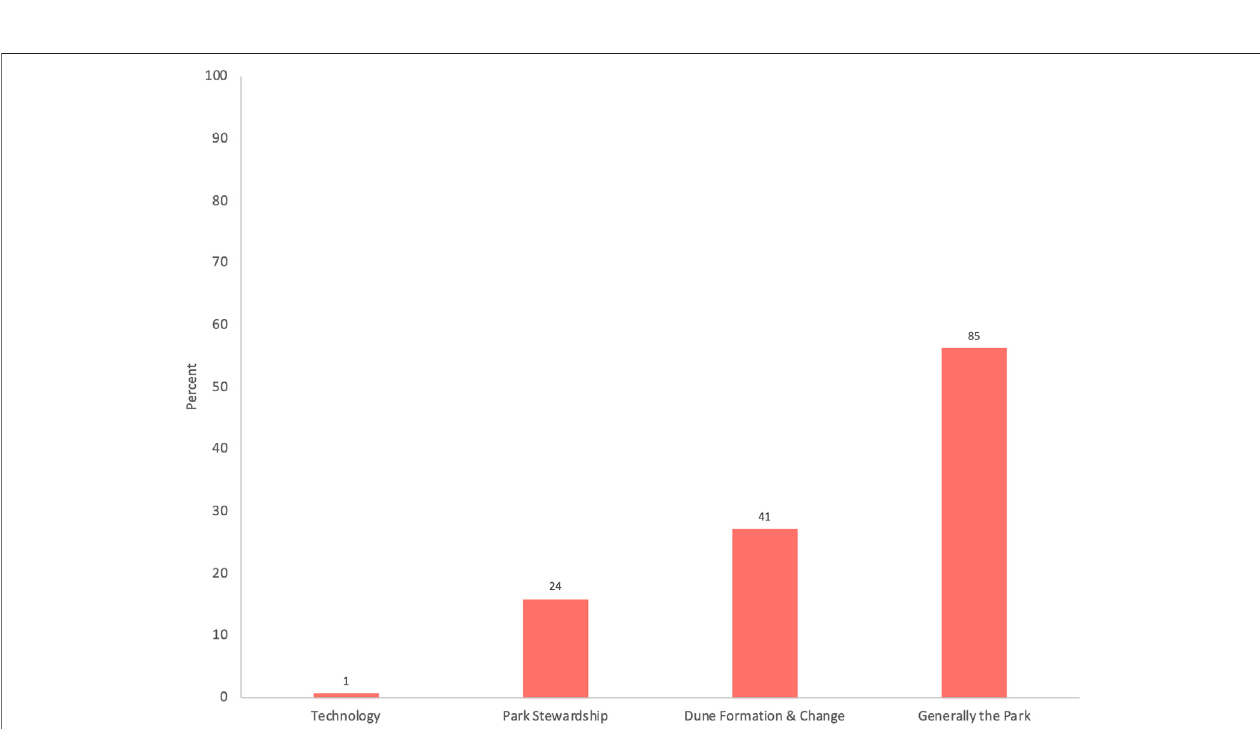
FIGURE 4 | Science content recalled from Mount Baldy Hike ( n (cid:1) 151).